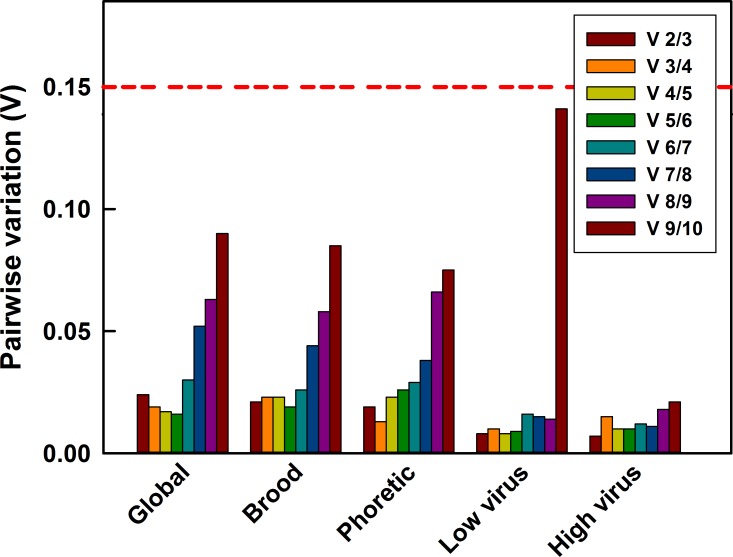
Pairwise variation analysis to determine optimum number of reference genes for accurate normalization.A pairwise variation analysis (geNorm) globally for all samples (n = 12) as well as subset analysis on brood mite samples (n = 3), phoretic mites (n = 3), Low virus mites (n = 3) and High virus mites (n = 3). Each sample comprised 8 pooled mites. Pairwise variation is compared with 0.15, below which the inclusion of a subsequent reference gene is not necessary to ensure accurate normalization.